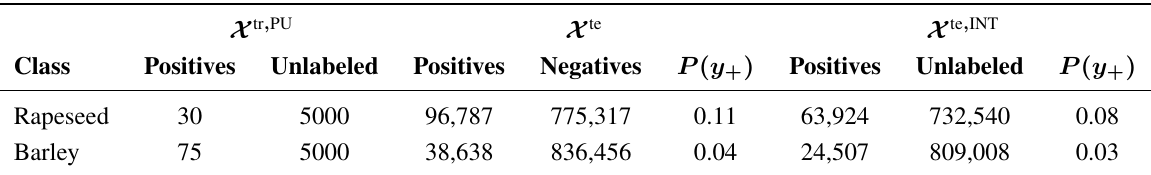
Table 2. Overview over the training ( X tr , PU ) and the two test set sizes, where X te comprises all pixels of the test fields and X te , INT only the interior fields. X tr , PU X te X te ,